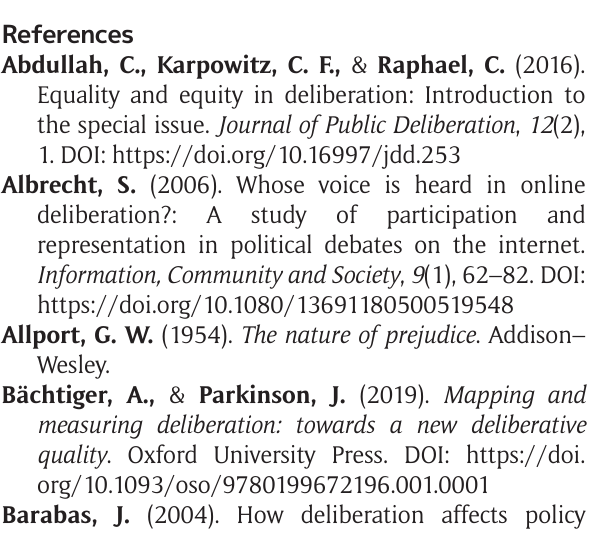
Supplementary file 1: The data related to the experiments and the content